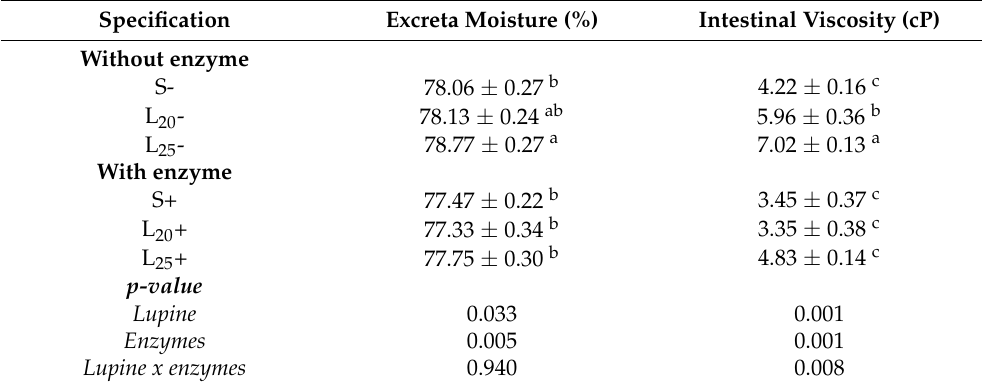
Table 4. Influence of enzymes addition in lupine-based diets on the excreta moisture and intestinal viscosity of the quails (mean ± std. error).